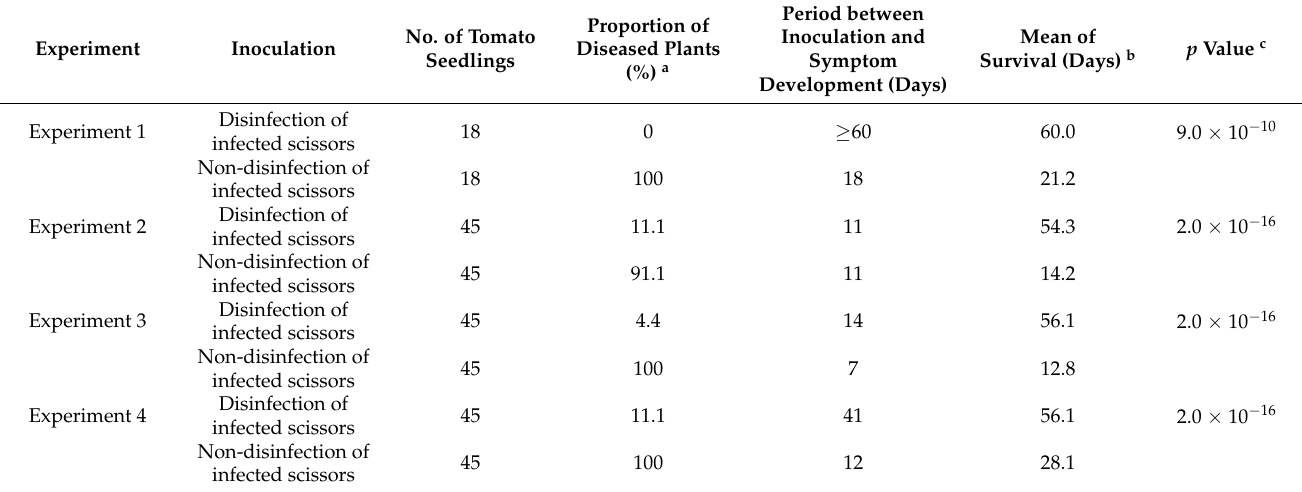
Table 1. Effects of ethanol disinfection on disease development and plant